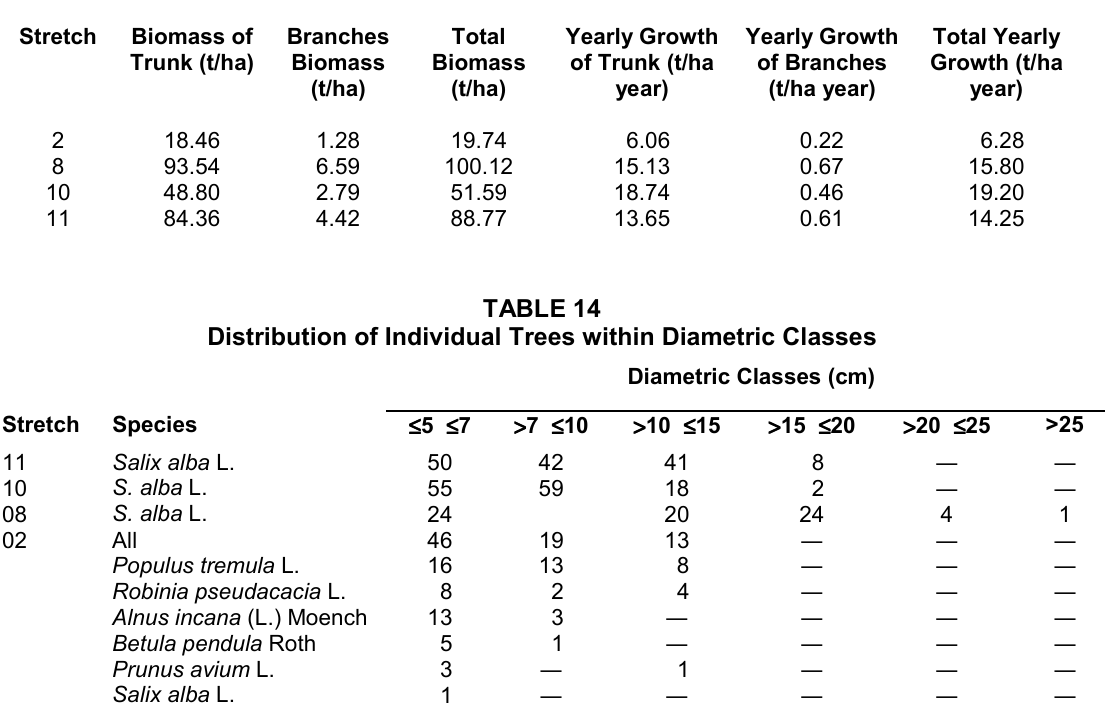
Biomass of Trees and Their Yearly Growth in a Hectare